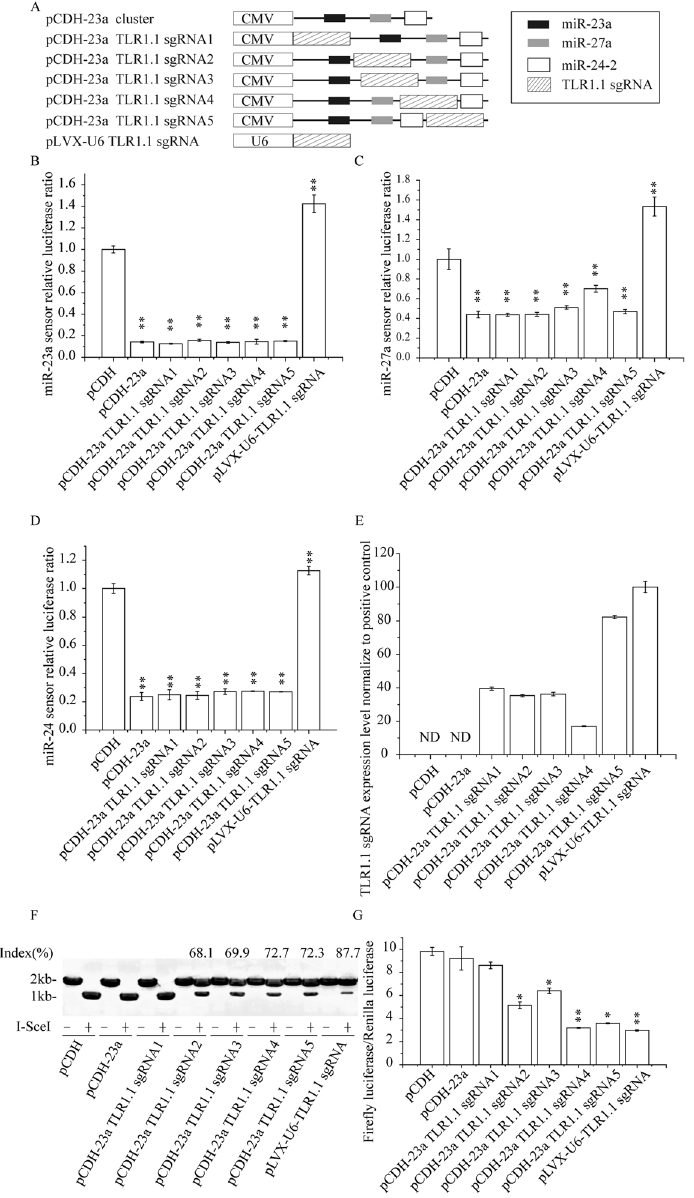
Figure 3. Polycistronic miRNA-based sgRNA construction produced active miRNA and sgRNA. ( A ) Designment and structure of miR-23a/27a/24-2 cluster based TLR1.1 sgRNA cassettes. TLR1.1 sgRNA was inserted into miR-23a/27a/24-2 cluster at indicated positions to construct five different miR-23a/27a/24-2 cluster based TLR1.1 sgRNA constructions. Based on the insertion position, these five sgRNAs constructions were respectively termed as pCDH-23a TLR1.1 sgRNA1, 2, 3, 4, 5. ( B – D ) miRNA sensors were used to detect the expression of miR-23a ( B ), miR-27a ( C ) and miR-24-2 ( D ). 293T cells were transfected with miRNA luciferase sensor constructions containing the sequence targeted by indicated miRNA as well as miRNA-based sgRNA constructions described above. Cells co-transfected with the reporter plasmid and empty vector (pCDH) served as a negative control, while cells co-transfected with the reporter plasmid and miR-23a cluster expression vector (pCDH-23a cluster) served as a positive control. Silencing activity was measured as the ratio of Renilla to firefly luciferase activity in cell lysates at 48 h after transfection, and results were normalized to corresponding negative control. Data were represented as the mean ± standard deviation (SD) of triplicate assays. ( E ) qRT-PCR were performed to evaluate the expression level of mature sgRNA. ND represents no detectable PCR products after 30 cycles. ( F , G ) miRNA based sgRNA expressed with CMV promoter can be used as a tool for genome editing. Indicated miRNA based sgRNA expression vector, Cas9 expression vector, pGL3-control NHEJ V2 vector (containing an I-SceI nuclease/TLR1.1 sgRNA target site) and pRL-TK vector were co-transfected into 293 T cell. Six days after transfection, the cells were harvested and then used as temples for I-SceI digestion assay ( F ) and luciferase reporter assay ( G ) to evaluate the nuclease activity of sgRNAs driven by different